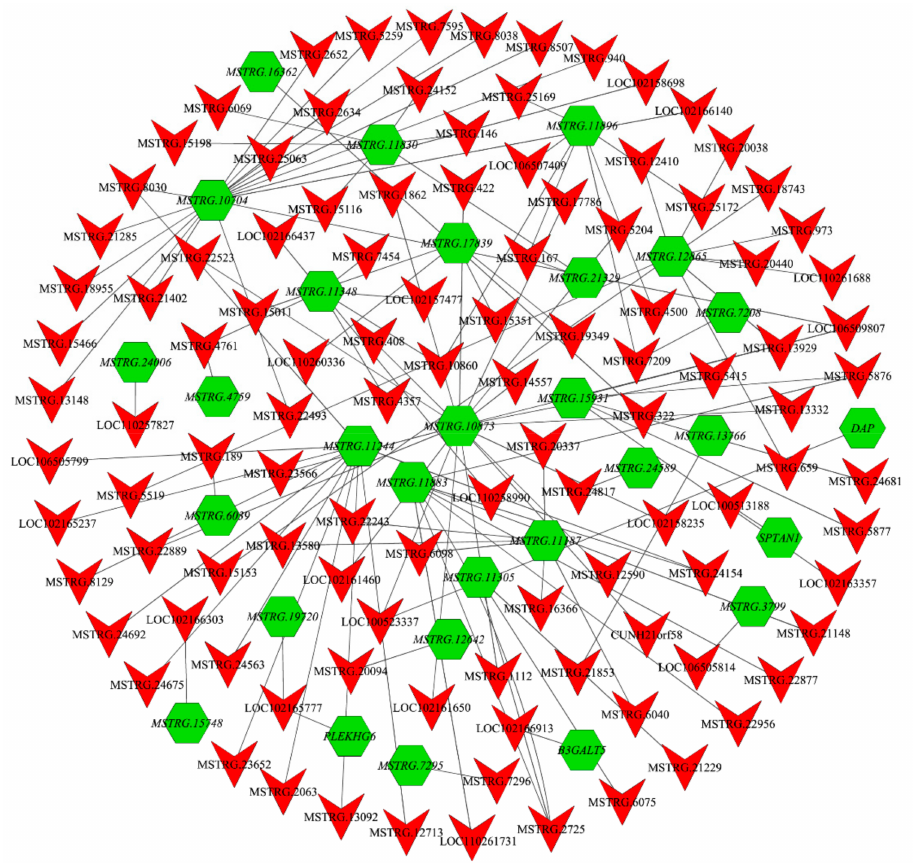
Figure 6. The network between DE lncRNAs and target DE mRNAs. Nodes represent lncRNA or mRNA, and edges represent the interaction between lncRNA and mRNA. Inverted triangles (red, regular) and hexagons (green, italic) represent lncRNA and mRNA,